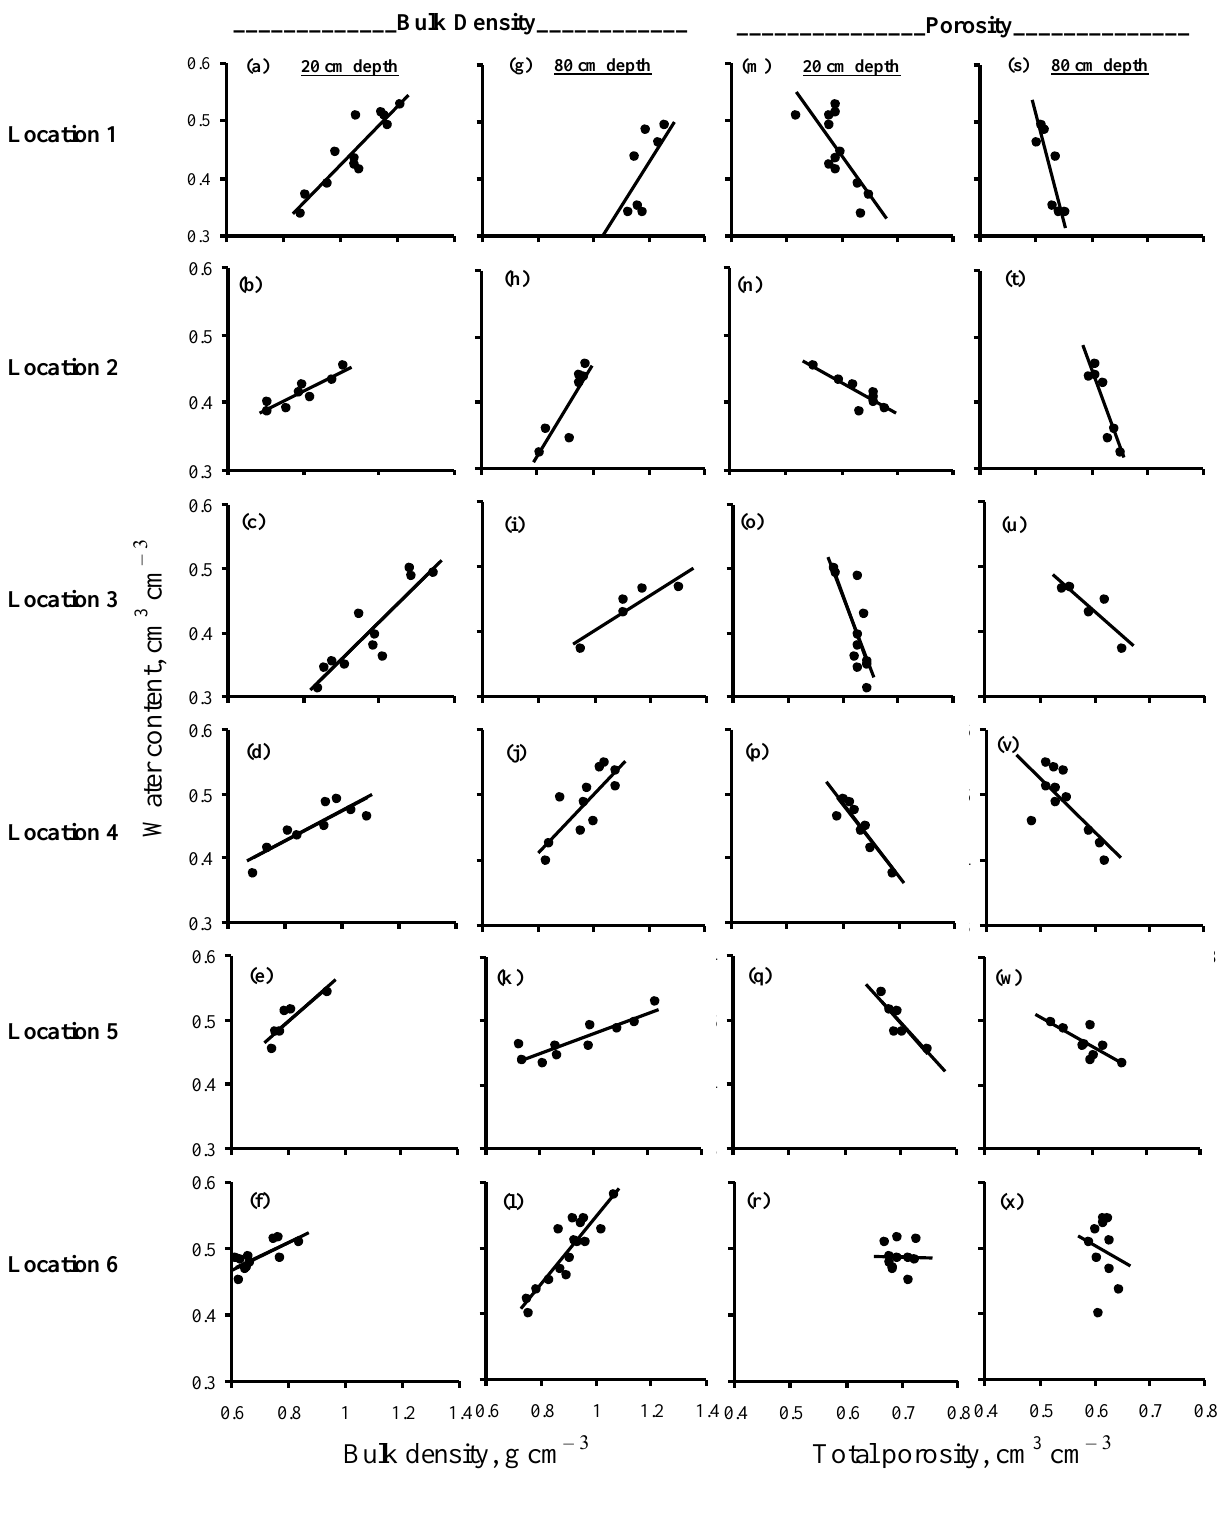
Figure 3. Effect of spatial variability of soil bulk density (figures on left) and actual total porosity (figures on right) on field measured soil water